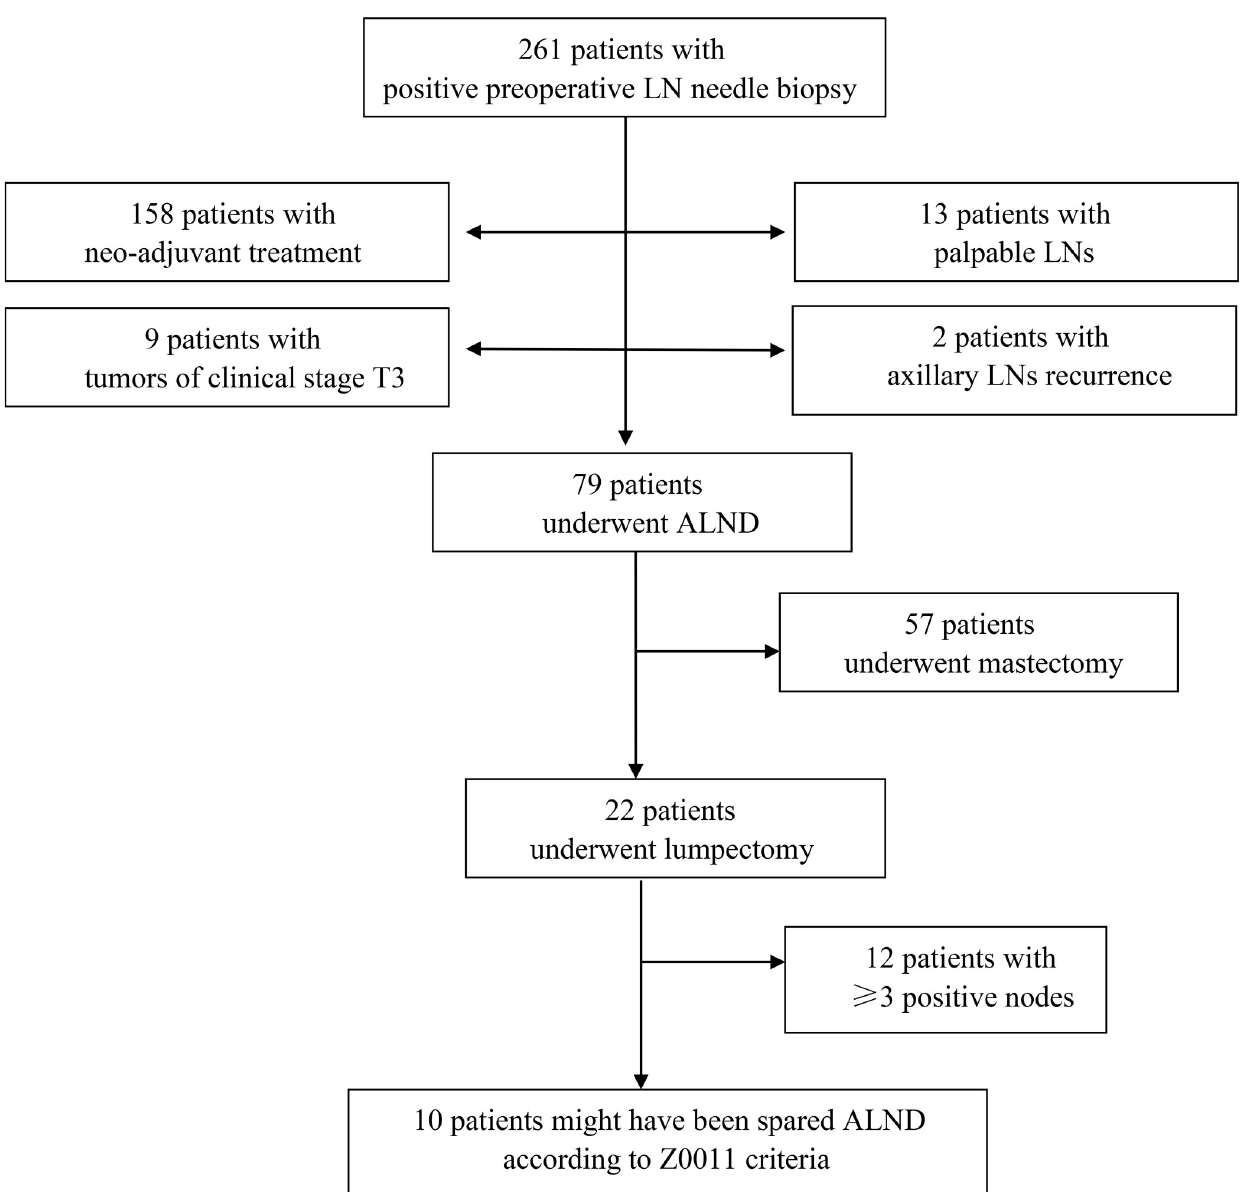
Fig 1. Flow chart of the study procedures. (LN-lymph node; ALND-lymph node dissection).